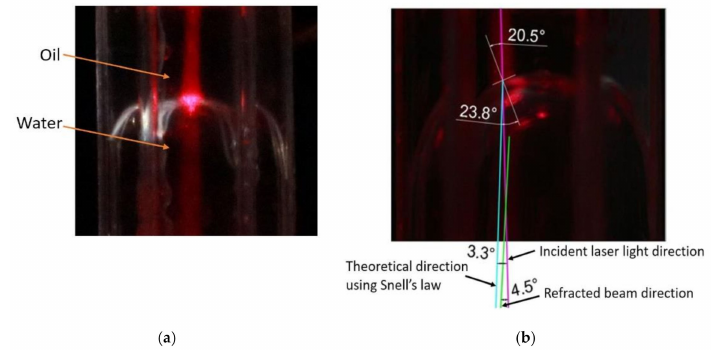
Figure 15. ( a ) The laser light path at 0 V and ( b ) steering of laser light due to the deflection of the interface with 26 V applied to the two right adjacent electrode